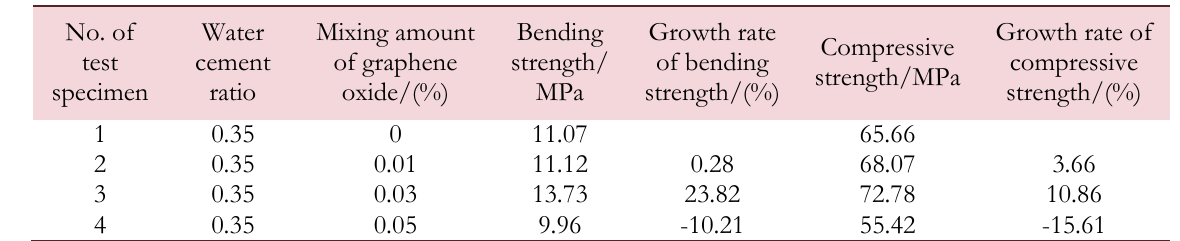
Table 2: The basic mechanical properties of cement mortar under different mixing amount of graphene oxide.